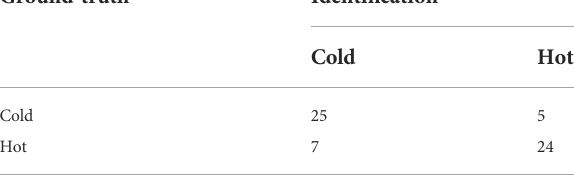
TABLE 5 Confusion matrix of 61